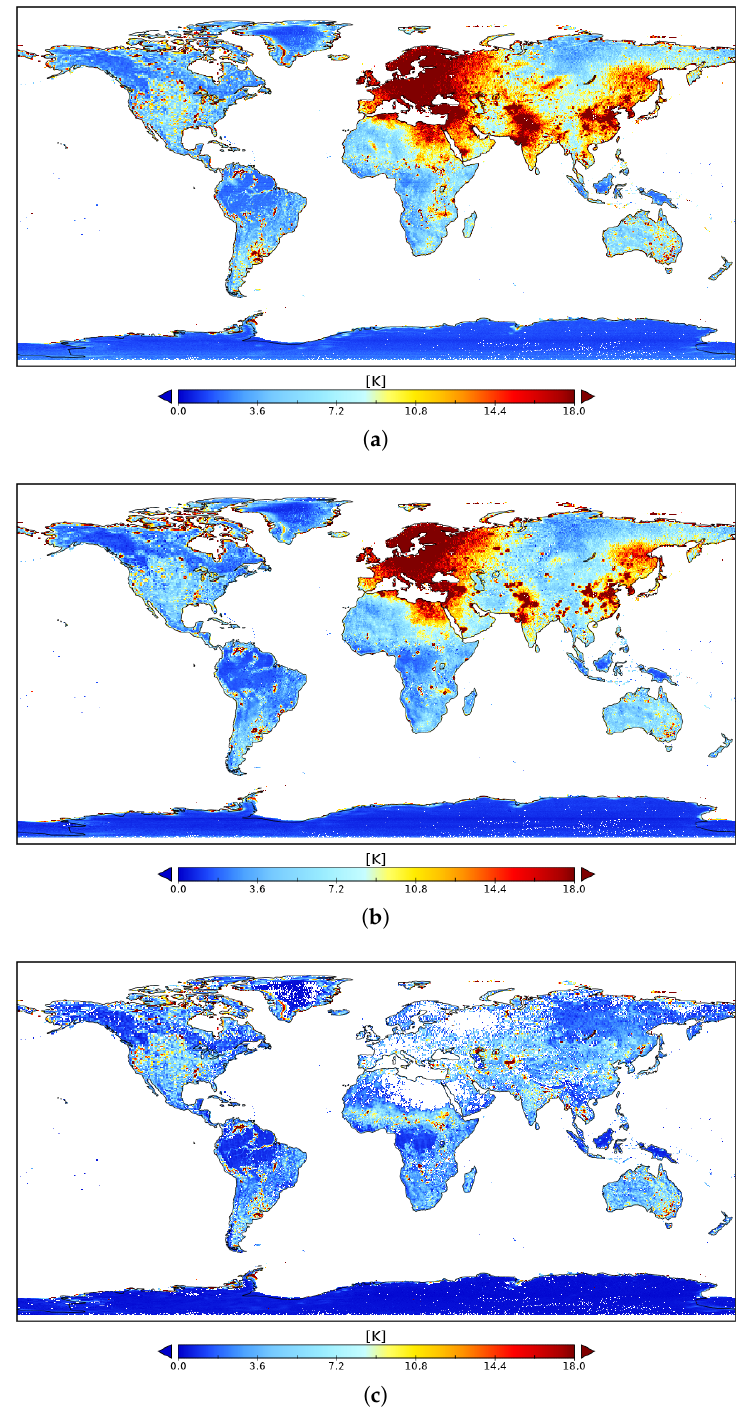
Figure 10. Maps of the error standard deviation of brightness temperature (TB) ( σ δ (mean error std: 7.23 K and gaps: 1.02%), ( b ) SMOS NS (mean error std: 6.2 K and gaps: 1.34%), and ( c ) SMAP (mean error std: 3.18 K and gaps: